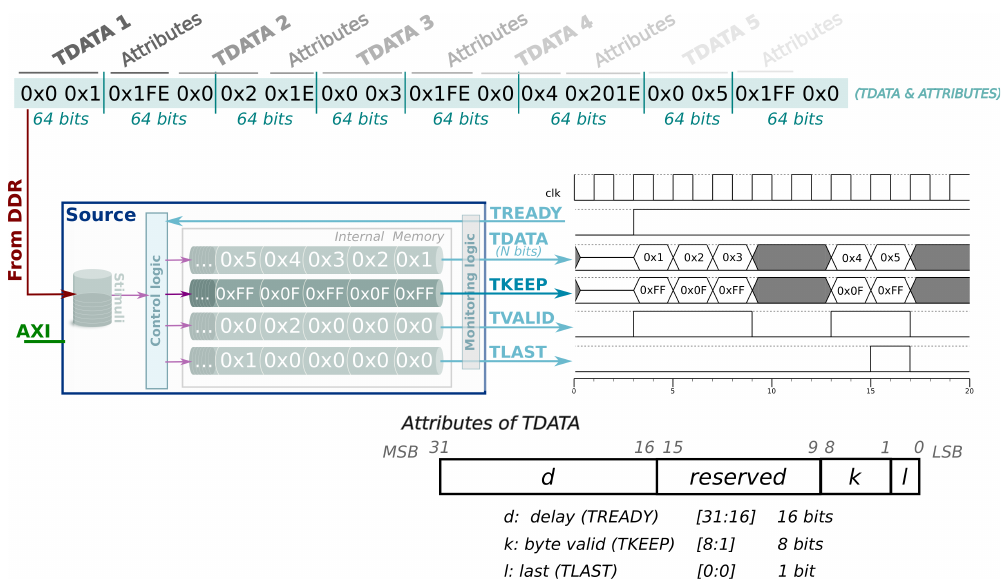
Figure 4. Block and timing diagram example of source component (with TKEEP